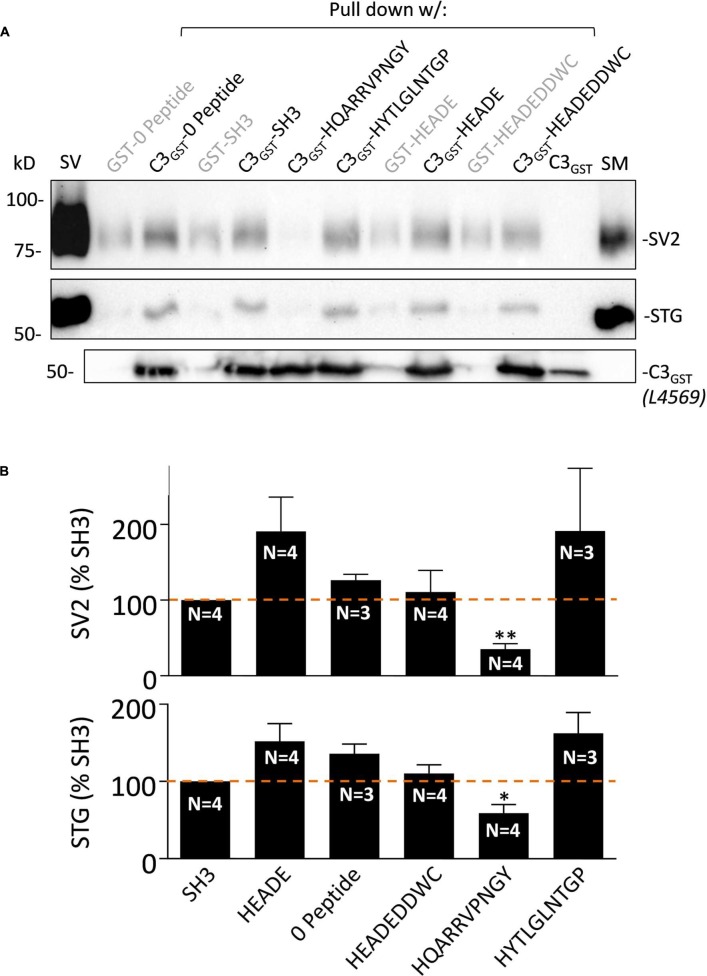
HQARRVPNGY inhibits SV-PD with native C3 fusion protein.
(A) The effect of HQARRVPNGY on SV capture as in Figure 2 was repeated using C3GST probing for SV2 and STG (0.6 mM peptide). (B) The peptide inhibited SV-PD compared to SH3 peptide whereas three control peptides, a zero peptide control and also one other test peptide, HYTLGLNTGP, had no effect. Both SV2 and STG exhibited increased mean band intensities with HEADE but this did not reach statistical significance (t-test, p > 0.1) while HEADEDDWC was unchanged. ∗p < 0.05, ∗∗p < 0.01.